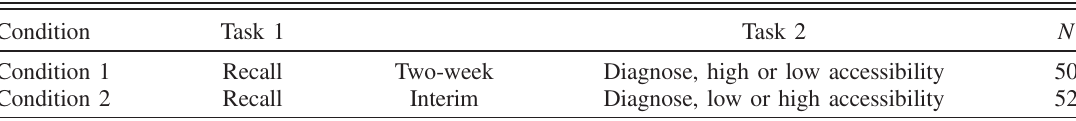
TABLE XI. Experiment 4